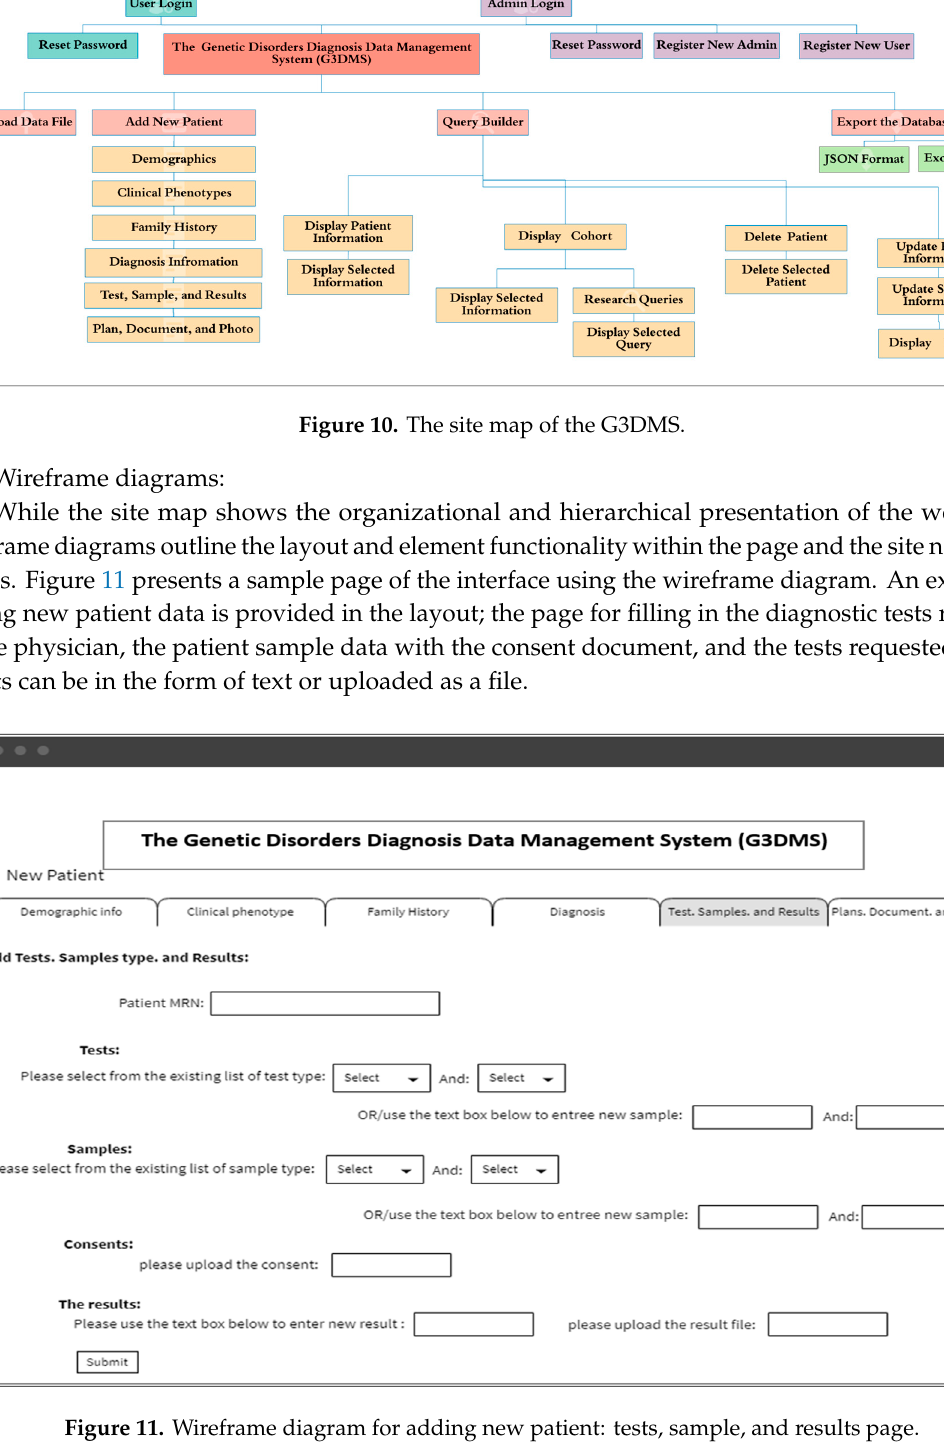
Figure 11. Wireframe diagram for adding new patient: tests, sample, and results page.